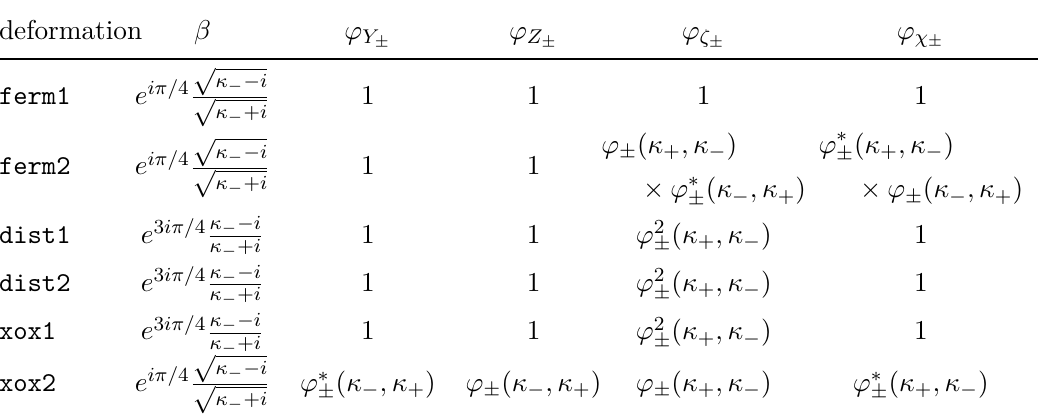
, ϕ , ϕ , and ϕ in eq. (3.1). We include them χ ± Y ± Z ± ζ ± ( κ , κ ) ± 1 2